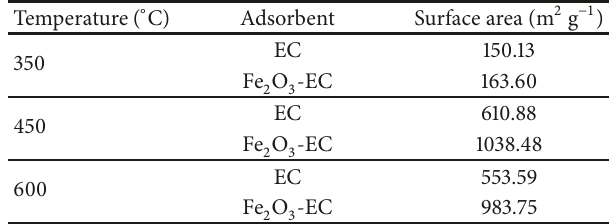
Table 1: Specific surface areas of EC and Fe 2 O 3